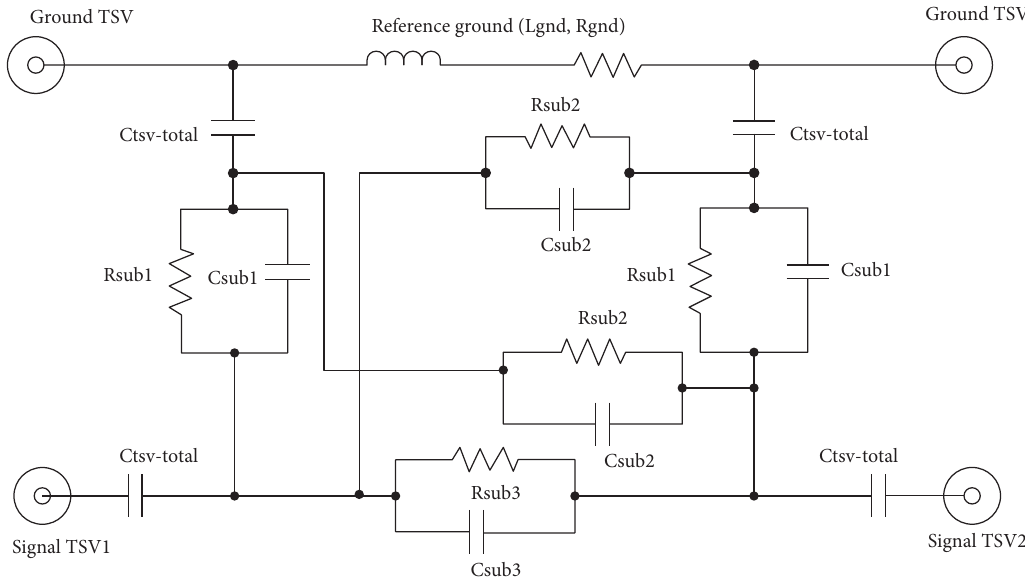
Figure 4: The equivalent circuit model of TSV-TSV noise coupling.